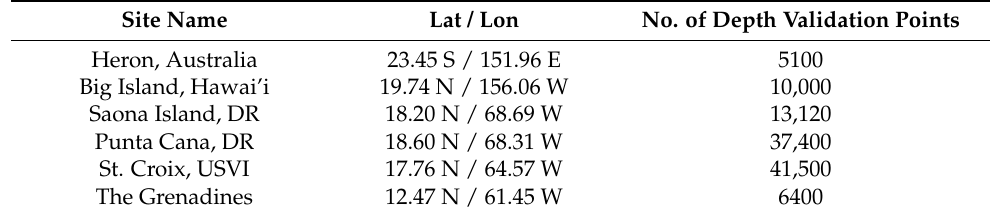
Table 1. Location of field sampling sites and the number of depth validation